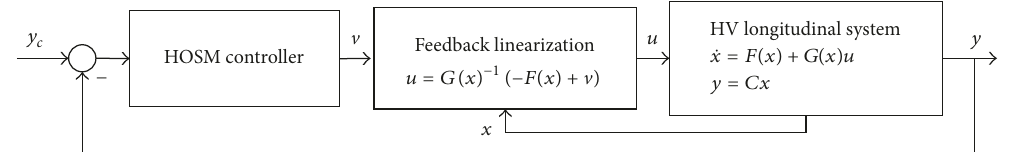
Figure 1: HV control structure based on HOSM.